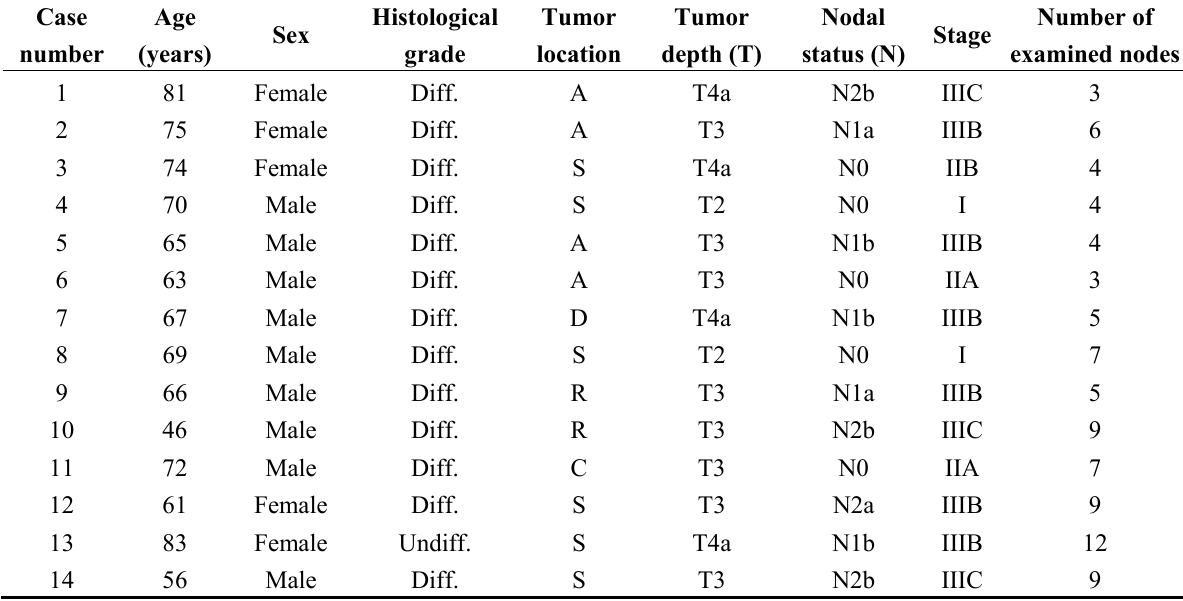
Table 1. Clinicopathological characteristics of enrolled patients and examined lymph